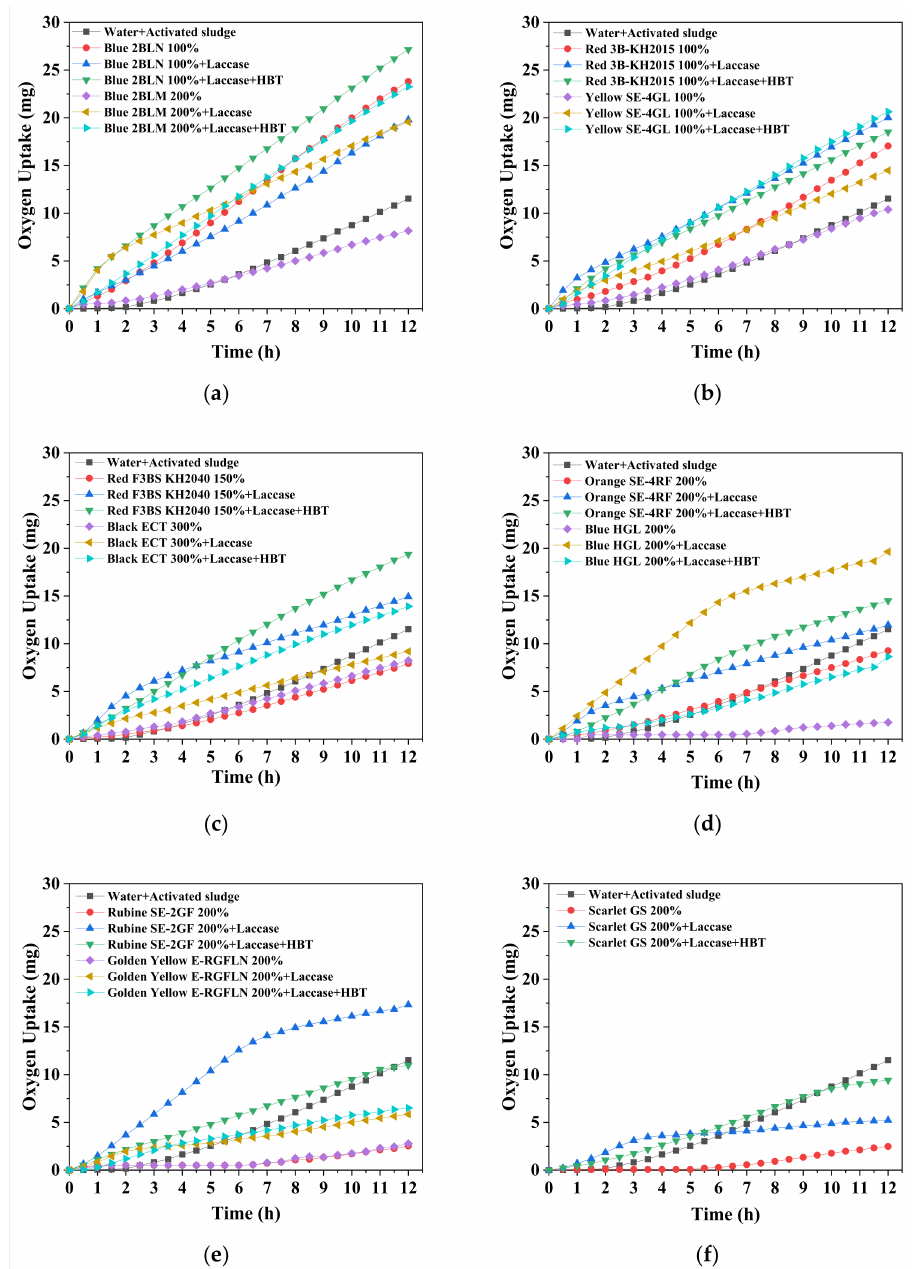
Figure 6. Oxygen uptake by aerobic AS exposed to 11 synthetic dye solutions under different treatments: deactivated laccase, laccase, and laccase + HBT. ( a ): Blue 2BLN 100% and Blue 2BLM 200%; ( b ): Red 3B-KH2015 100% and Yellow SE-4GL 100%; ( c ): Red F3BS KH2040 150% and Black ECT 300%; ( d ): Orange SE-4RF 200% and Blue HGL 200%; ( e ): Rubine SE-2GF 200% and Golden Yellow E-RGFLN 200%; ( f ): Scarlet GS